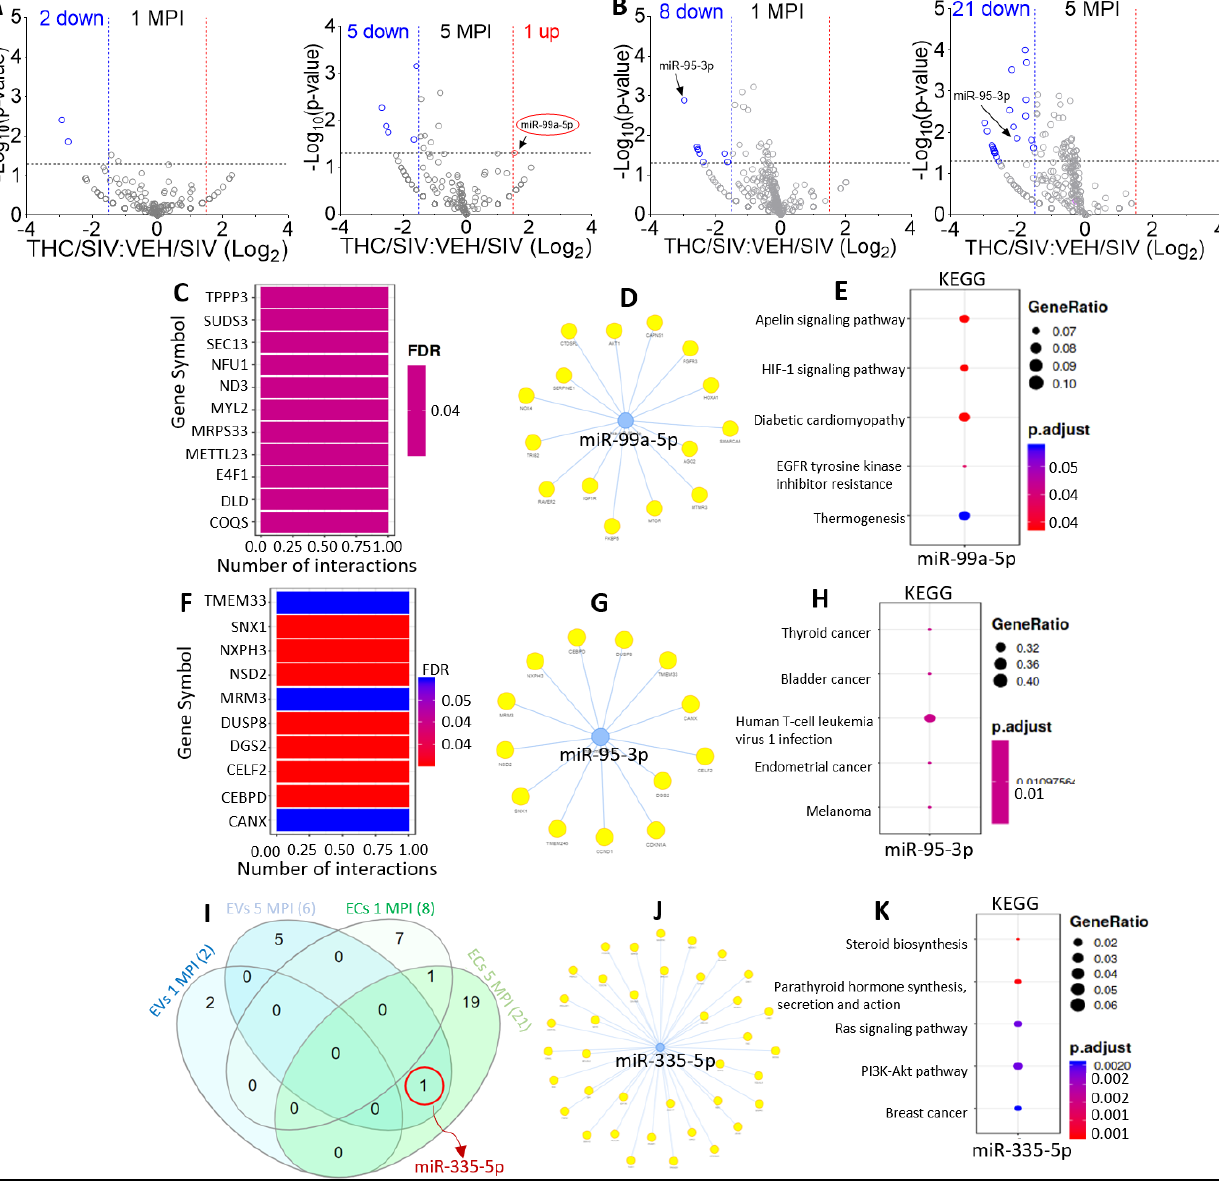
Figure 4. Alterations in miRNA profile of THC-treated SIV-infected cART-naive RMs. ( A ) Volcano plot showing down-(blue) regulated and up-(red) regulated miRNAs in THC/SV EVs relative to VEH/SIV EVs at 1 MPI (left) and 5 MPI (right). Red circle indicates miRNAs suppressed by SIV infection miR-99a-5p. ( B ) Volcano plot showing down-(blue) regulated and miRNAs in THC/SIV ECs relative to SIV ECs at 1 MPI left) and 5 MPI (right). Black arrows indicate miRNAs shown to be significantly downregulated at both MPI and 5 MPI. ( C ) miRNA-target enrichment analysis showing top target genes by number of interactions for miR-99a-5p. ( D ) Visualization of miRNA- target interaction network for miR-9a-5p. The blue circles represent the miRNAs, while the target genes are represented by the yellow circles. Pathways are represented by blue lines. ( E ) Dot plot of functional enrichment analysis for target genes of miR-99a-5p. Color of dots represent adjusted p-values (FDR) and size of dots represents gene ratio (number of miRNA targets found enriched in each category/number of total genes associated to that category. ( F ) miRNAtarget enrichment analysis showing top target genes by number of interactions for the EC-associated miRNA